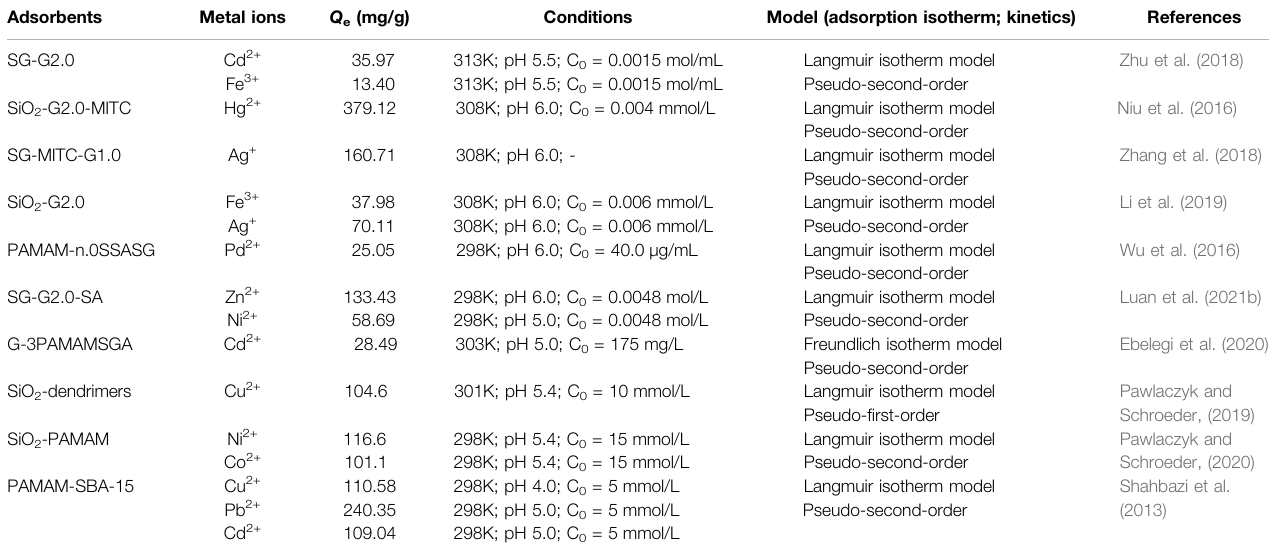
TABLE 3 | Heavy metal ions adsorption by polyamide amine/silicon-based composites.